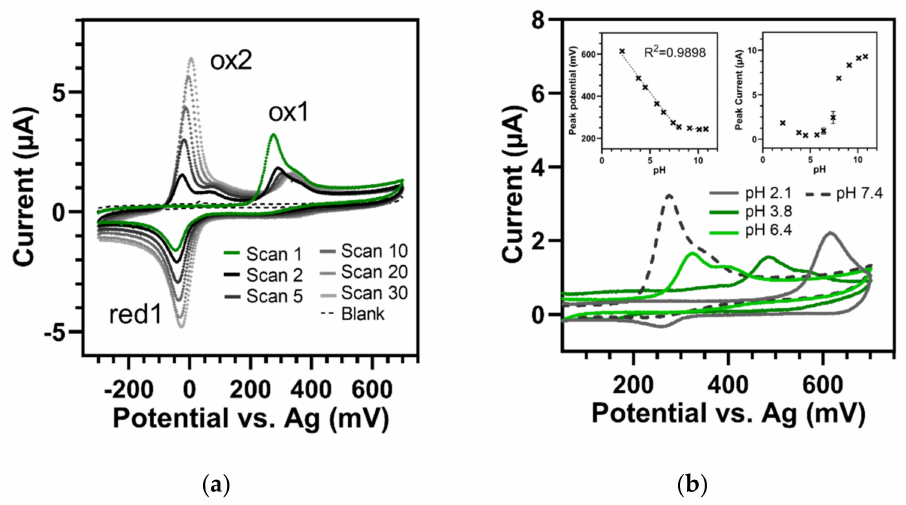
Figure 4. Cyclic voltammetry of 250 µ M HQNO (100 mV/s). ( a ) Thirty CV cycles in buffer of pH 7.4. In the first cycle (green), one defined oxidation peak (ox1) occurred at 274 mV and one reduction peak (red1) at − 46 mV. In the following cycles (black to light grey), ox1 dropped, while the second oxidation peak (ox2) at − 24 mV and the shoulder at approx. 70 mV, as well as red1, increased continuously. Blank = pH 7.4 buffer. ( b ) Dependency of ox1 on buffer pH. Left insert: Shift in oxidation peak potentials versus pH (pH 2.1–10.8). Right insert: Peak current versus pH. Error bars represent standard deviations of three